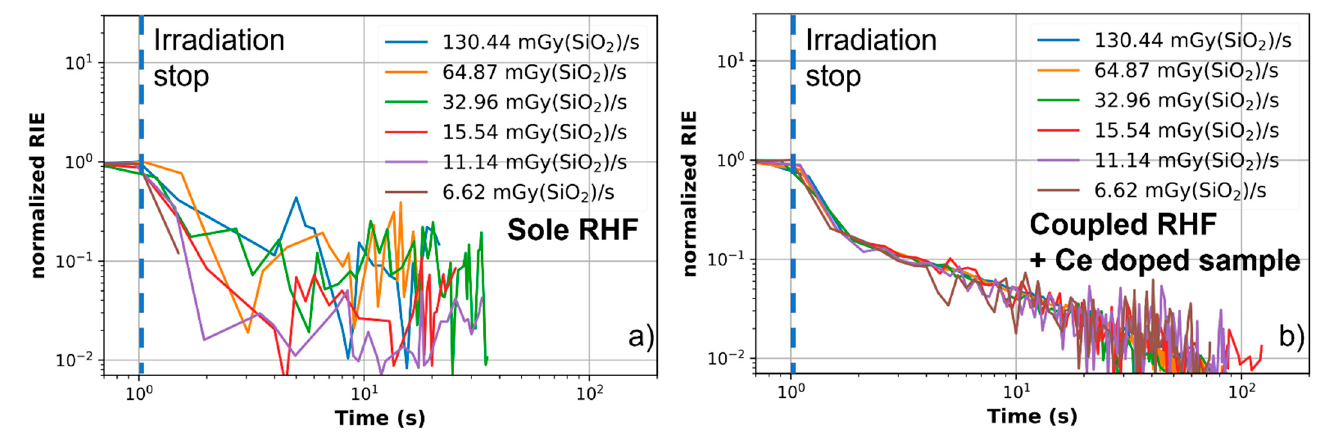
Figure 8. ( a ) RIE decay of the sole RHF under ORIATRON X ‐ ray beam. ( b ) RIE decay of the coupled RHF + Ce ‐ doped OF under ORIATRON X ‐ ray beam.